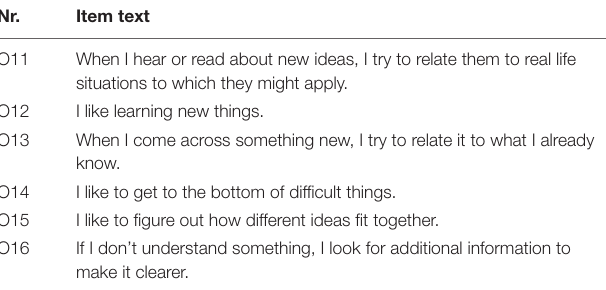
TABLE 1 | Items of 2012 Openness measure (“learning strategies” in PIAAC background questionnaire).